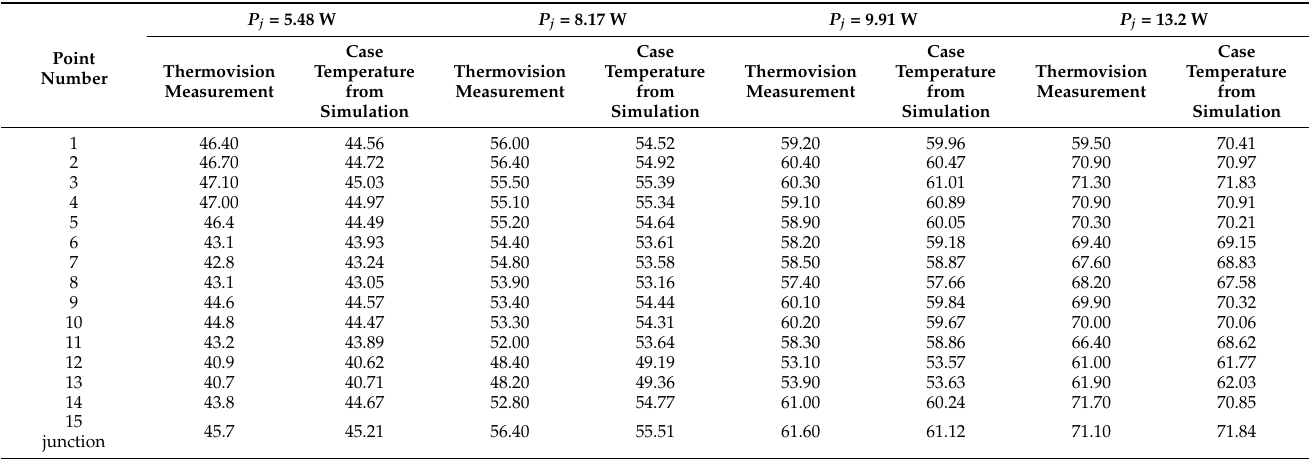
Table 7. Comparison of the point temperature values obtained on the basis of simulations with the results of thermovision temperature measurements made for these points.